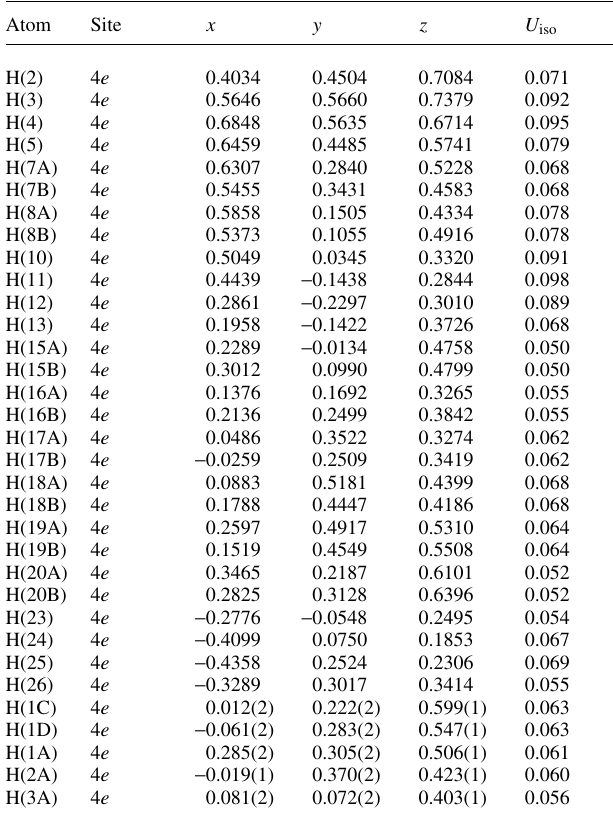
Table 2. Atomic coordinates and displacement parameters (in Å 2 )